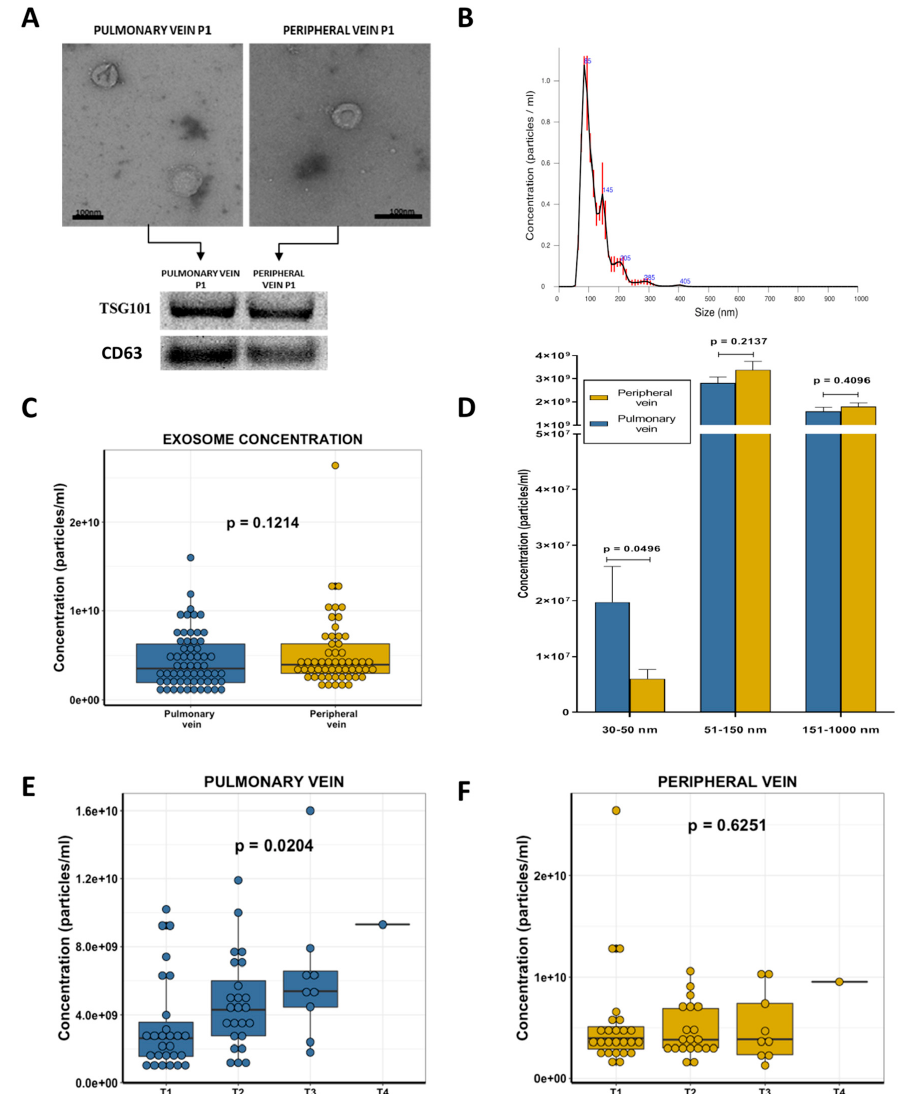
Figure 1. ( A ) Exosomes were characterized by transmission electron microscopy using negative staining and Western blot using the exosome marker TSG101. ( B ) The quantification and size analysis were performed by Nanosight. An example of the size distribution graph obtained is shown. ( C ) Boxplot showing exosome levels in pulmonary and peripheral vein in non-small cell lung cancer (NSCLC) patients. ( D ) Bar plot showing exosomal size levels in pulmonary and peripheral vein according to three size groups: 30–50 nm, 51–150 nm and 151–1000 nm. ( E ) Boxplot showing pulmonary vein exosome levels according to T stage in NSCLC patients. ( F ) Boxplot showing peripheral vein exosome levels according to T stage in NSCLC